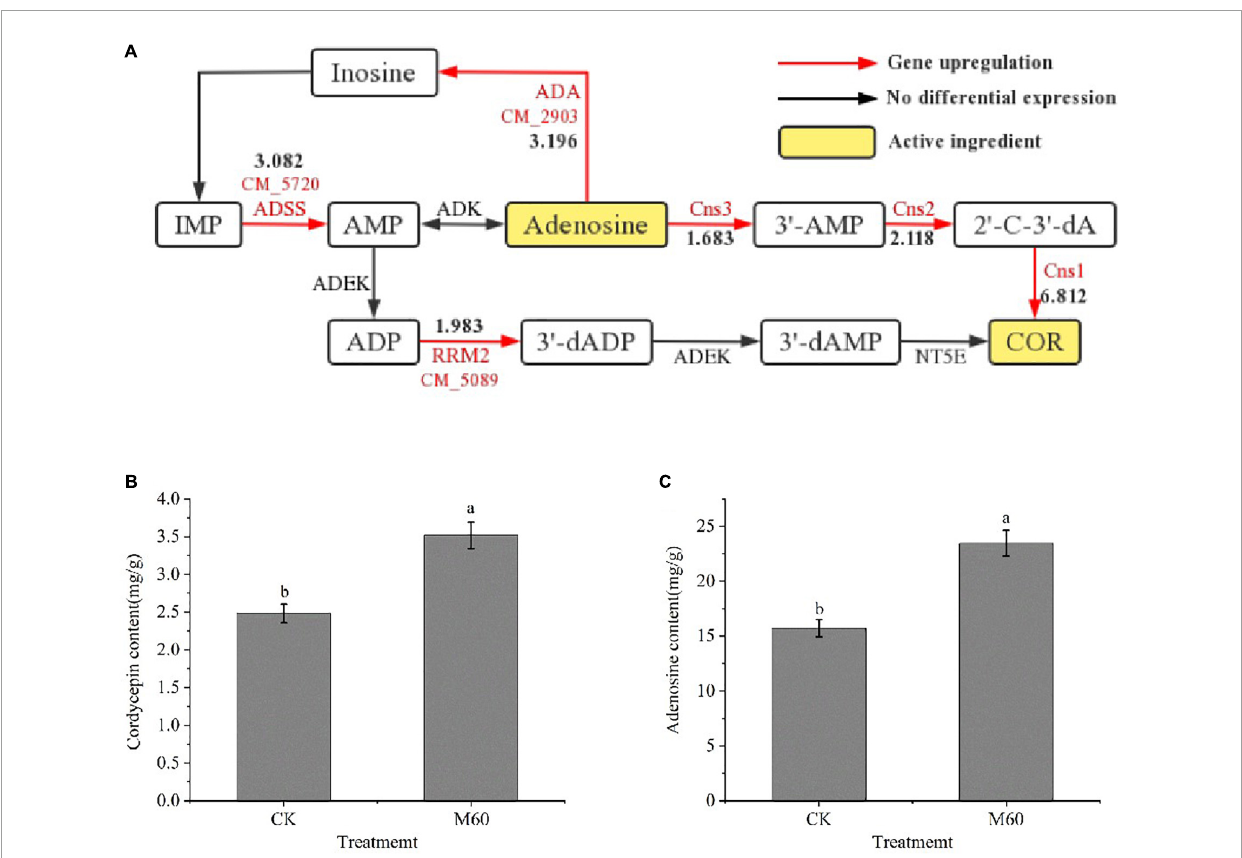
FIGURE7 Accumulation of active components in C. militaris strain CK vs. M60 after MT treatment. (A) Biosynthetic pathway of cordycepin and expression of related DEGs. The red mark next to the red line represents the DEGs, and the black number represents the DEGs expression. (B) Cordycepin content of CK and M60. (C) Adenosine content of CK and M60. The different letters represent significant differences among treatments according to Duncan’s multiple range tests ( p < 0.05). Data are represented as means ± SD, n = 3. M60, add 60 µ mol L − 1 of MT. IMP, inosine monophosphate; AMP, adenosine monophosphate; ADP, adenosine diphosphate; COR, cordycepin; ADSS, adenyl succinate synthetase; ADEK, adenylate kinase; NT5E, 5 (cid:48)